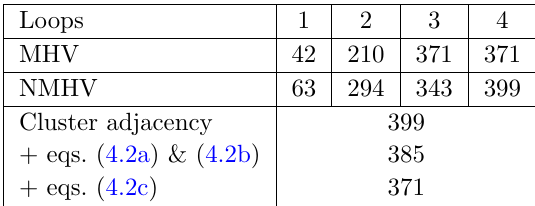
Table 3 . Number of unordered pairs of distinct consecutive letters in the symbols of the seven- particle amplitudes at given loop level. Note that all the found pairs obey general cluster adjacency, that is the letters appear together in a cluster of the E 6 cluster algebra. In the last three rows we give the number of consecutive pairs of letters that are theoretically possible considering the seven-particle alphabet and imposing only cluster adjacency or also the restrictions to